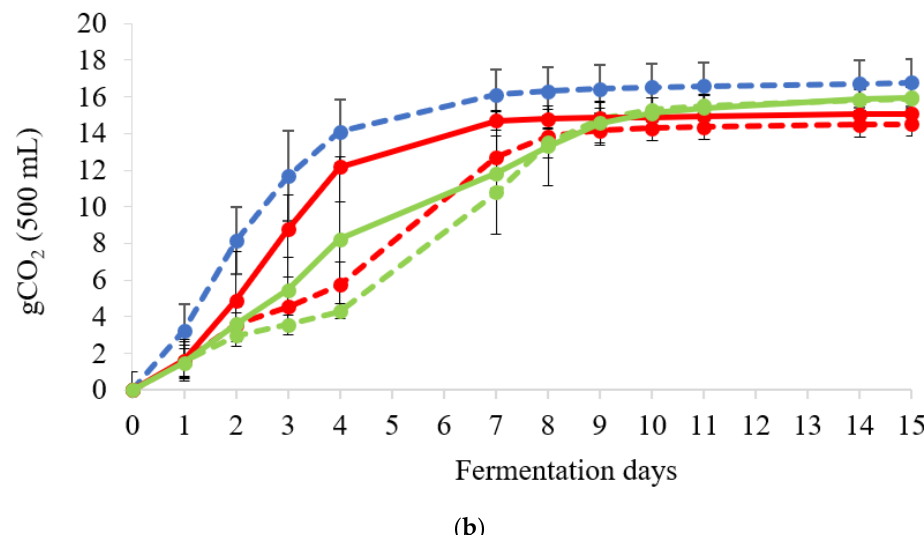
Figure 1. Fermentation kinetics of the pure and mixed fermentations in ( a ) PW and ( b ) PWL. Pure culture of S. cerevisiae ( ); L. thermotolerans ( ), and K. unispora ( ), and mixed fer- mentation of S. cerevisiae / L. thermotolerans ( ) and S. cerevisiae / K. unispora ( ). K. unispora and L. thermotolerans in pure fermentation showed slower fermentation